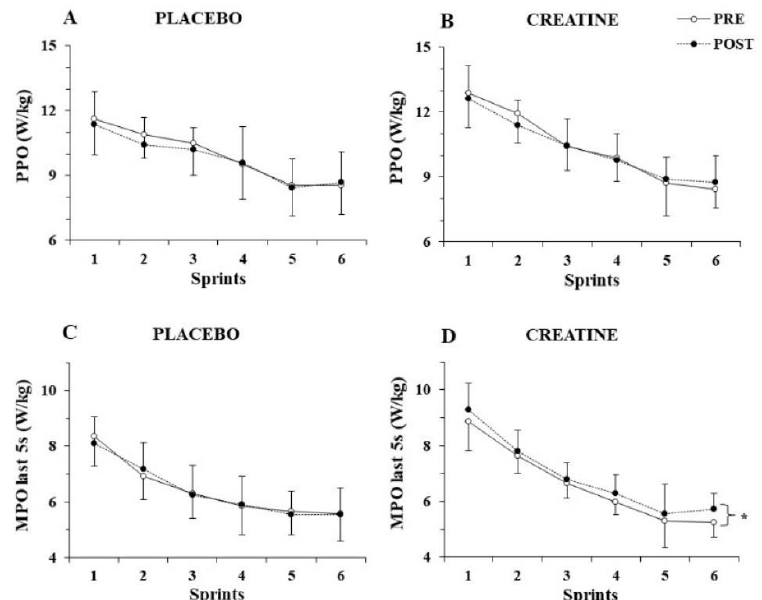
Figure 2. Peak power output (PPO) per kg of body mass ( A , B ) and mean power output (MPO) per kg of body mass during the last 5 s ( C , D ) of each sprint for the placebo and creatine groups pre- and post-supplementation. * p < 0.01 average of all sprints before vs. after supplementation. To further examine the distribution of power output during each sprint, MPO/kg was calculated during the first 5 s and the last 5 s of each sprint and analysed separately. While the three-way ANOVA for MPO/kg achieved during the first 5 s of each sprint did not show any interactions, but rather only a main effect of sprint number ( p < 0.001, η 2 = 0.89), the three-way ANOVA for MPO/kg during the last 5 s of each sprint showed a pre – post x group interaction ( p = 0.010, η 2 = 0.38), with the post hoc test revealing an average of 4.5% increase in mean power output during the last 5 s of the six sprints after Cr supple- mentation ( p = 0.005; Figure 2C,D). Only a main effect of sprint number ( p < 0.001, η 2 = 0.87) without any two-way or three-way interaction was shown by the three-way ANOVA for peak speed (Figure 3A,B). In contrast, a group x sprint interaction ( p = 0.004, η 2 = 0.46) and a group x sprint x pre – post supplementation interaction were found for mean speed ( p = 0.021, η 2 = 0.17), with the post hoc tests showing 4.6% and 6.9% increase in mean speed in sprints 5 and 6 ( p = 0.007 and p < 0.001, respectively. See Figure 3C,D).